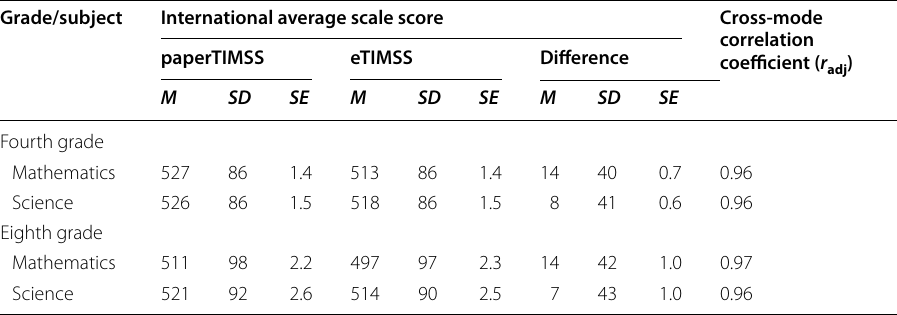
Because of rounding some results may appear